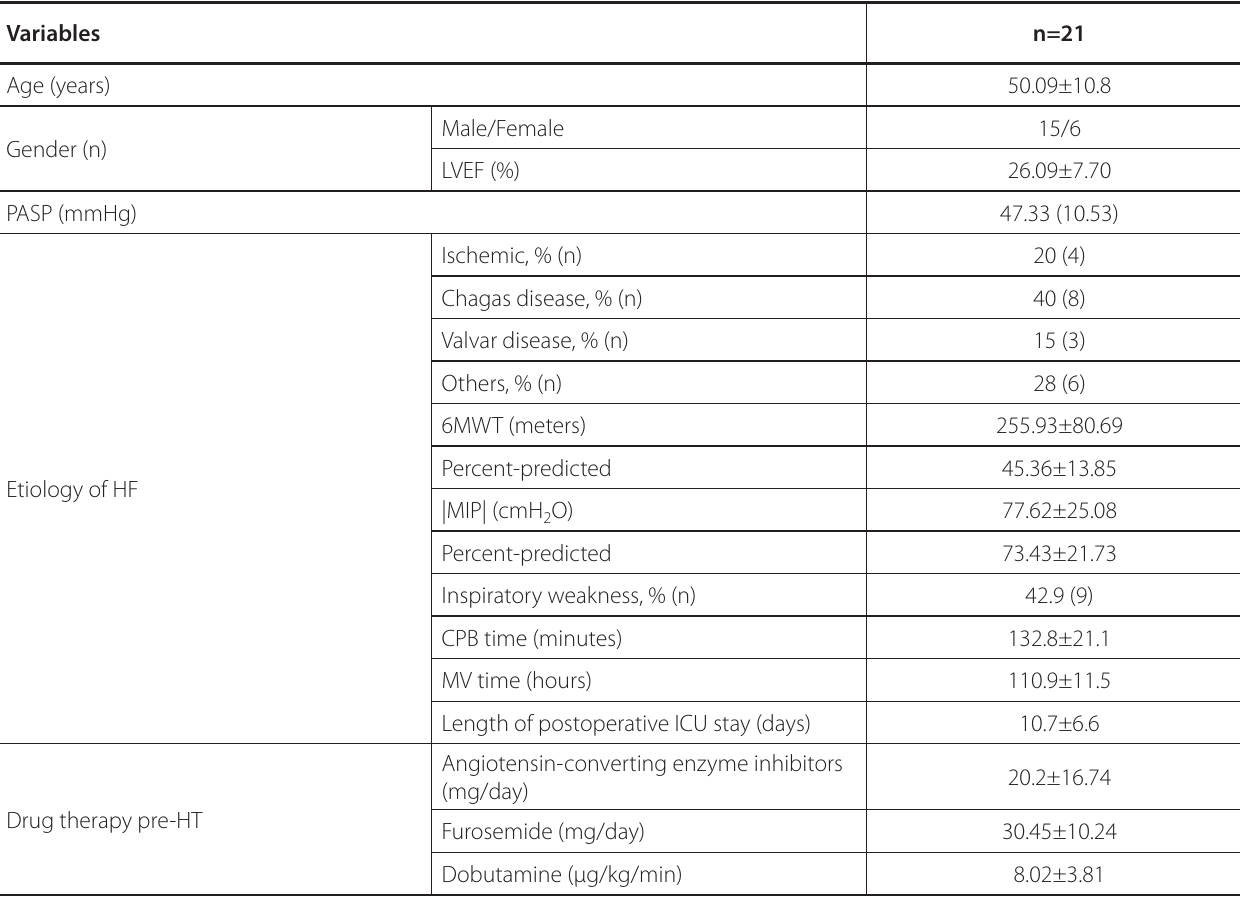
Table 1 . Clinical and anthropometric